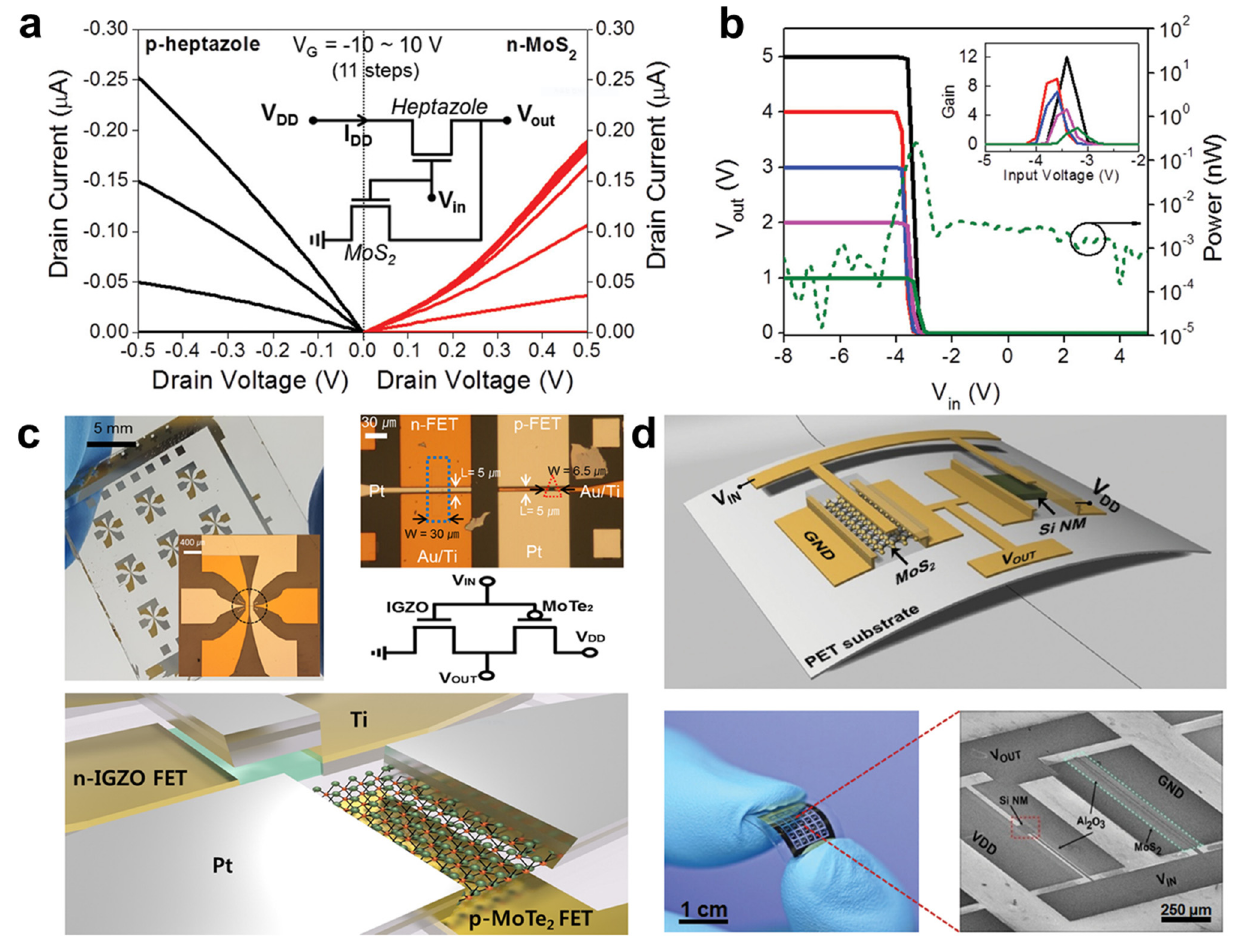
Figure 1. ( a ) I D – V D output curve of n- MoS 2 and p- heptazole channel FETs. ( b ) The voltage transfer characteristics of a hybrid CMOS inverter under supply voltages of 1 V to 5 V. The dashed curve shows power consumption at 1 V (adapted from [63] with permission from John Wiley and Sons). ( c ) Patterned CMOS inverter arrays, an OM image of the hybrid inverter fabricated on glass, and a 3D schematic of the hybrid CMOS inverter (adapted from [64] with permission from the American Chemical Society). ( d ) A 3D illustration of an Si NM-MoS 2 -based complementary inverter built on a plastic substrate, and a photographic image of a large-area 5 × 5 array of a CMOS inverter patterned on PET, where the magnified panel shows the scanning electron microscope (SEM) image (adapted from [65] with permission from John Wiley and Sons).